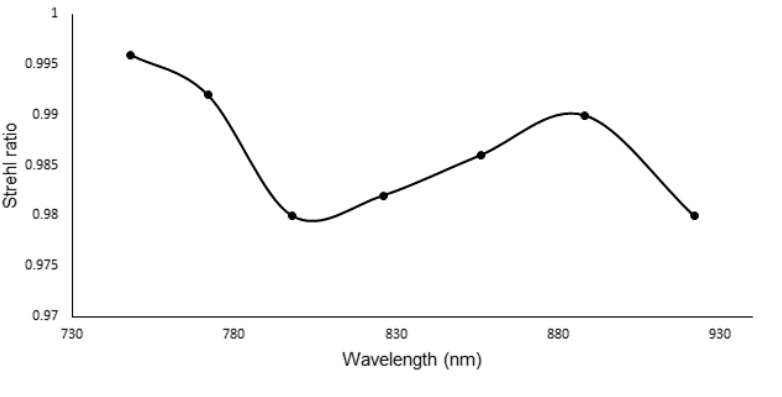
Figure 5. The Strehl ratio of the spectrometer with transmission grating.